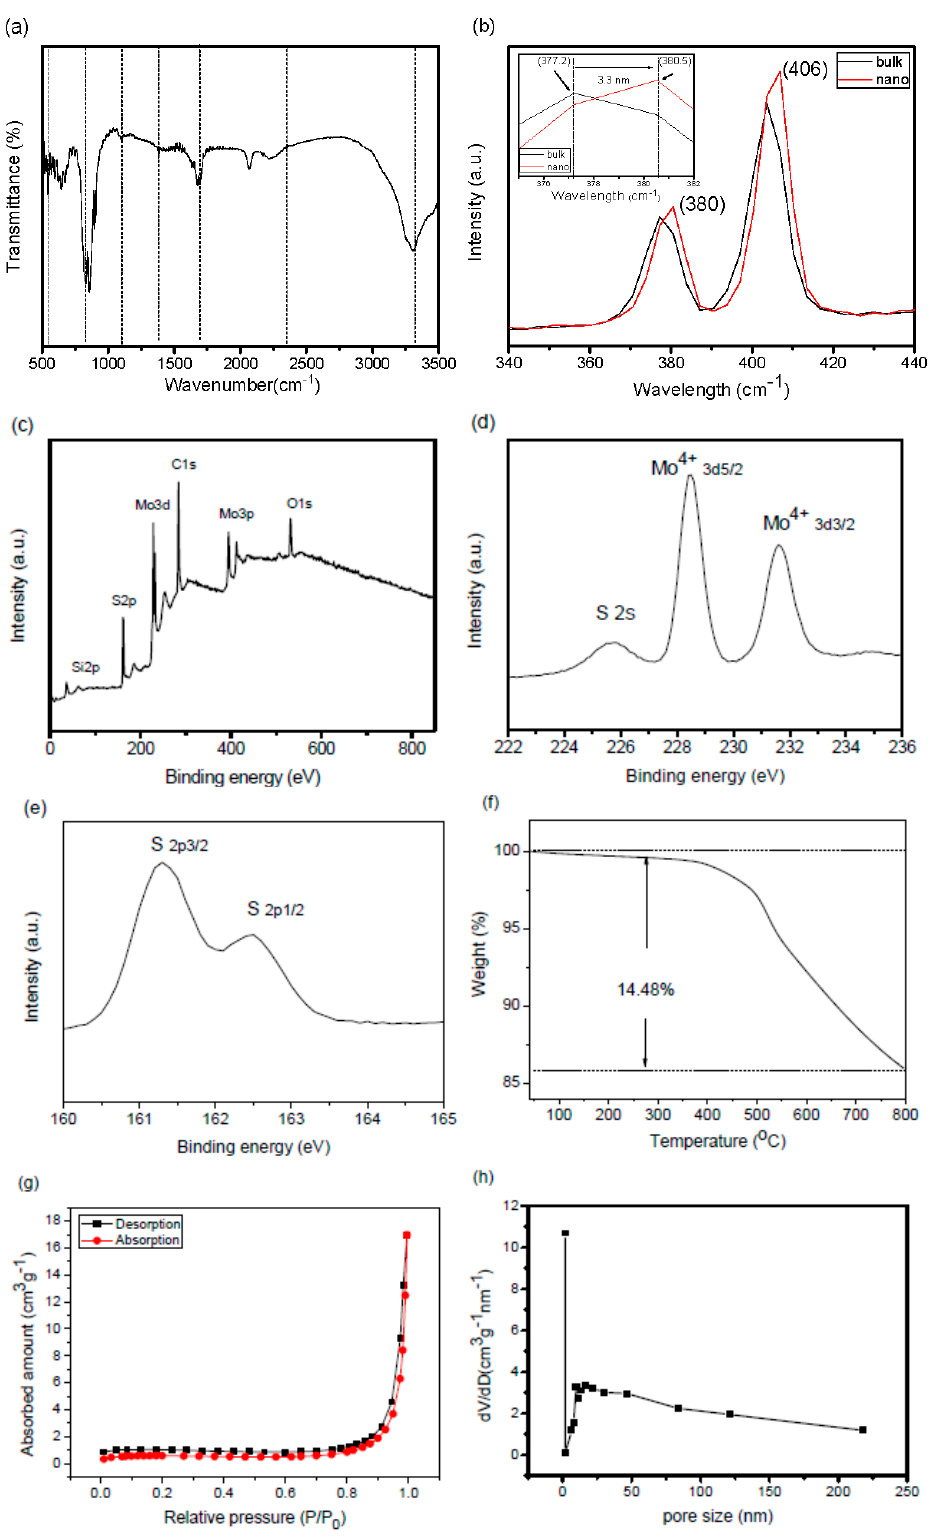
Figure 5. ( a ) The FTIR spectra of heterojunction photocatalysts, ( b ) Raman spectra, ( c ) overall XPS survey spectra of heterostructure materials, ( d ) XPS analysis of Mo 3d, ( e ) XPS analysis of S 2p, ( f ) TGA profiles, ( g ) N 2 adsorption / desorption isotherms, and ( h ) pore size distribution of 3 wt% CoO / meso–CN / MoS 2 heterostructure